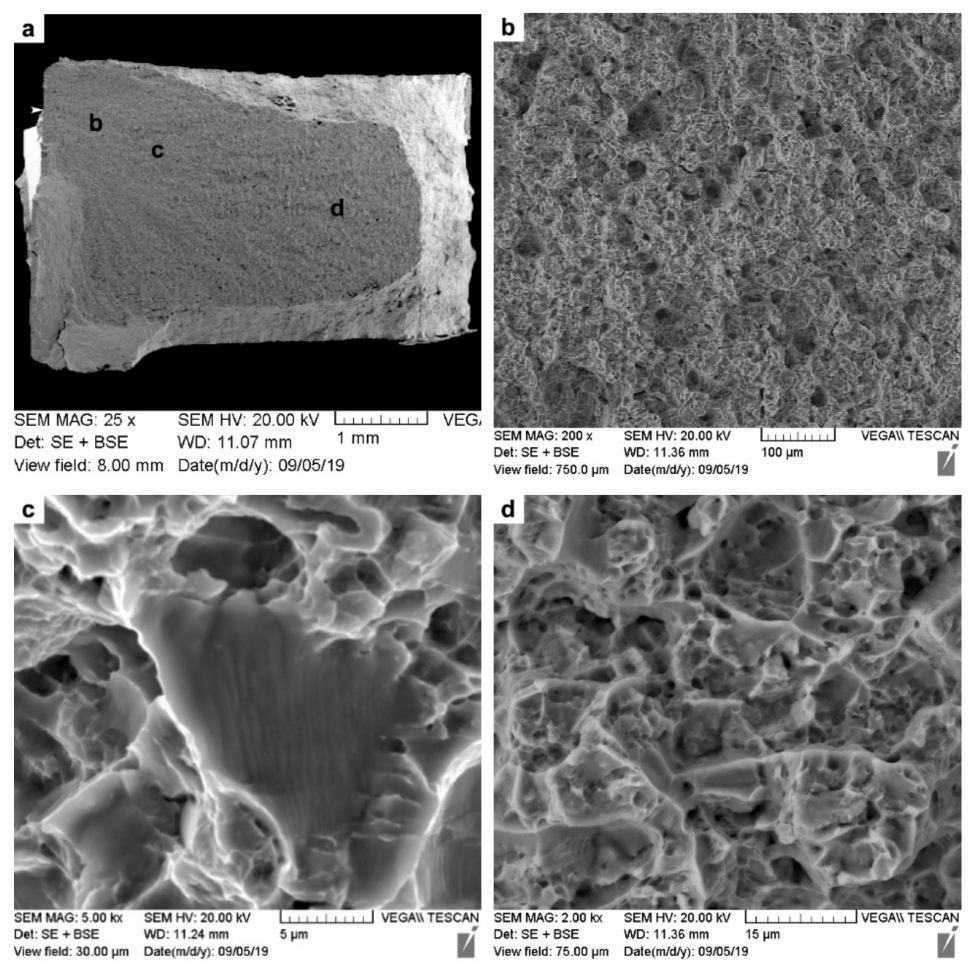
Figure 13. SEM images of the LCF fatigue fracture surfaces of the SRAed Ti-6242 welds: ( a ) overview giving locations of ( b ) early crack growth region, ( c ) stable crack growth region, and ( d ) tensile overload or fast fracture